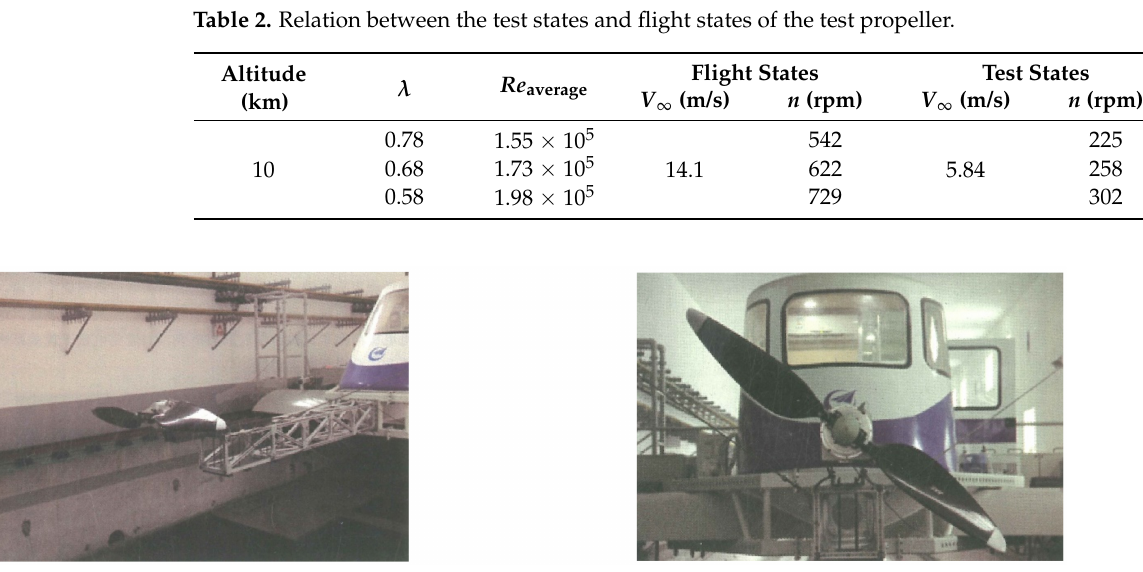
Figure 5. Ground experiment of the test propeller.